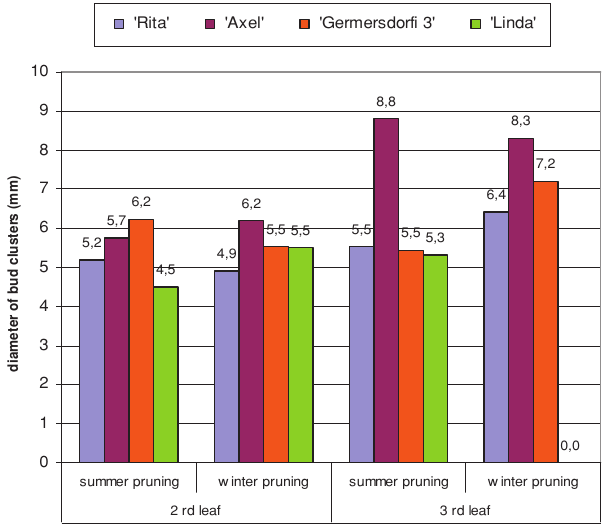
Figure 1 . The effect of pruning policies on the diameter of spurs developed on different ages of wood (2- and 3-year-old wood) (Debrecen–Pallag, 2009)